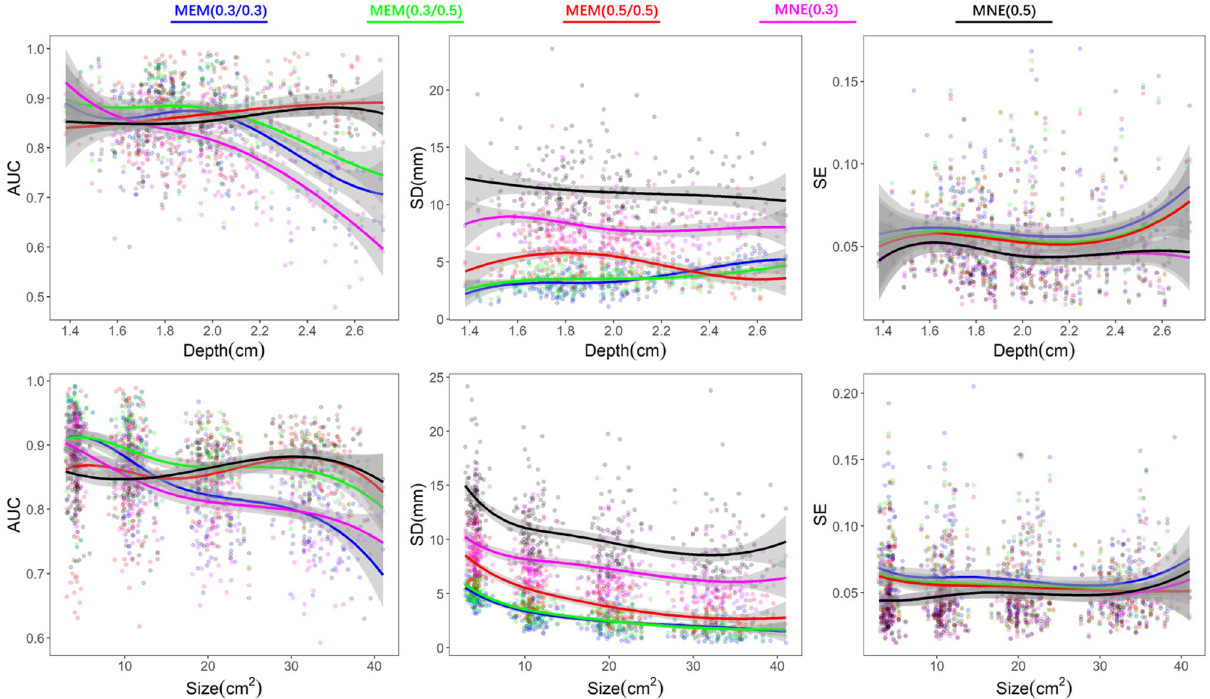
Figure 5. Effects of depth weighting on the depth and size of the simulated generators. First row demonstrates the validation matrices, AUC, SD and SE, as a function of depth of generators. We selected 250 generators created from all 250 seeds with a spatial extent of SD = 5 . Depth was calculated by the average of minimum Euclidean distance from each vertex, within each generator, to the head surface. Second row demonstrates the validation matrices, AUC, SD and SE, as a function of size of generators. Involving 400 generators which constructed from 100 superficial seeds with 4 different spatial extend of Se = 3, 5, 7, 9 . Line fittings were performed via a 4 knots spline function to estimate the smoothed trend and the shade areas represent 95% confident interval. Color coded points represent the values of validation matrices of all involved generators. Figure created by MATLAB version (R2016a) https:// www. mathw orks. com/ produ cts/ matlab.